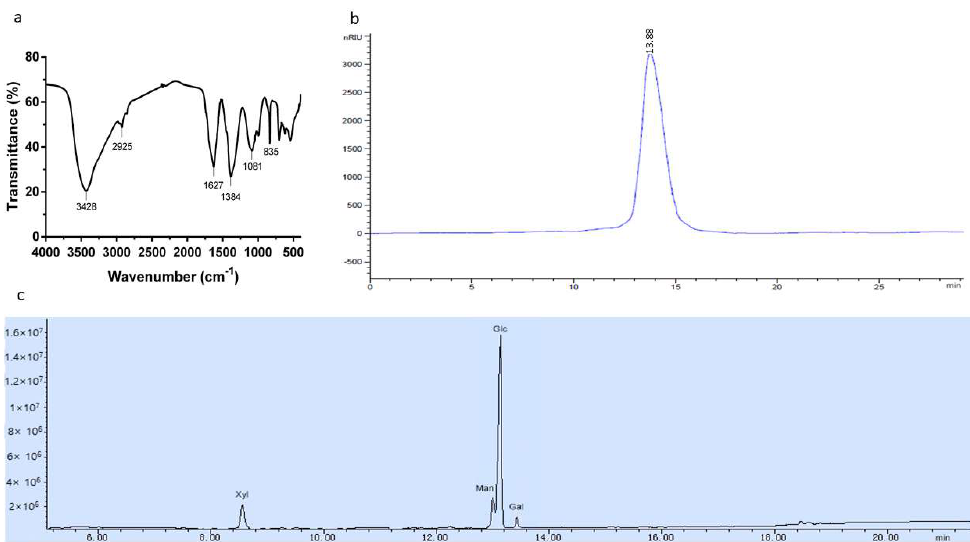
Figure 3. ( a ) FT-IR spectra of NMCP-2. NMCP-2 was measured in the range of 4000–400 cm −1 . ( b ) Molecular weights distribution of NMCP-2. The column was maintained at 20 ° C and eluted with 0.002 mol/L sodium dihydrogen phosphate at a flow rate of 0.6 mL/min. ( c ) Monosaccharide composition of NMCP-2 using gas chromatography-mass spectrometry (GC-MS).